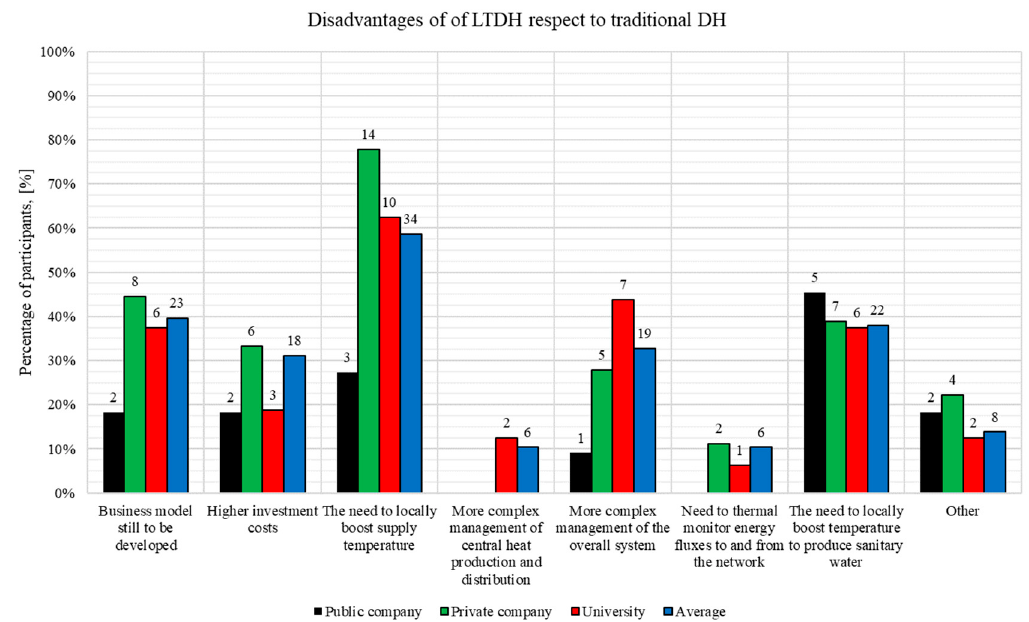
Figure 26. Disadvantages of LTDH systems with respect to traditional DH as a function of the organization type.